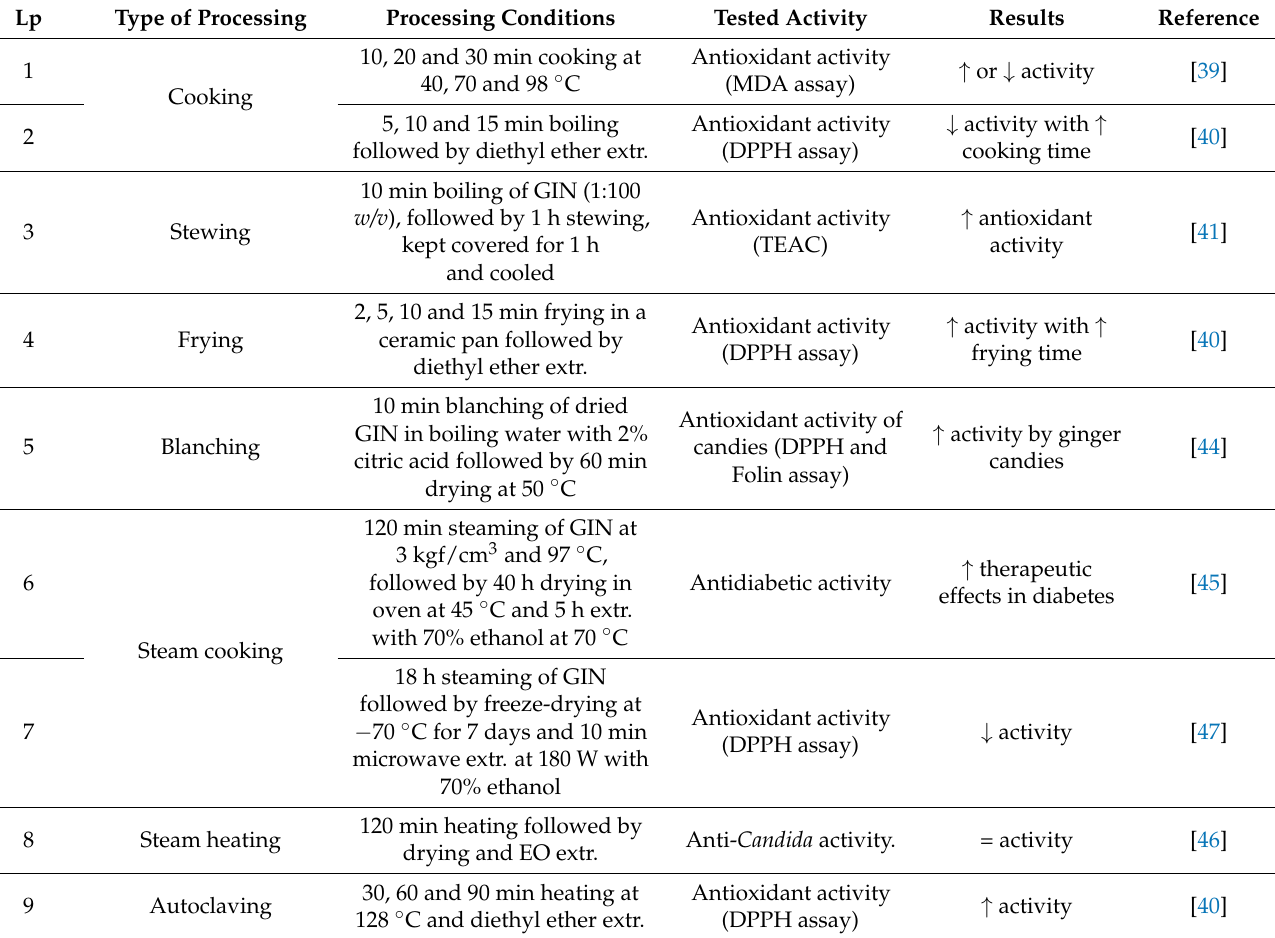
Table 1. Effect of traditional processing on pharmacological activity of ginger Zingiber officinale